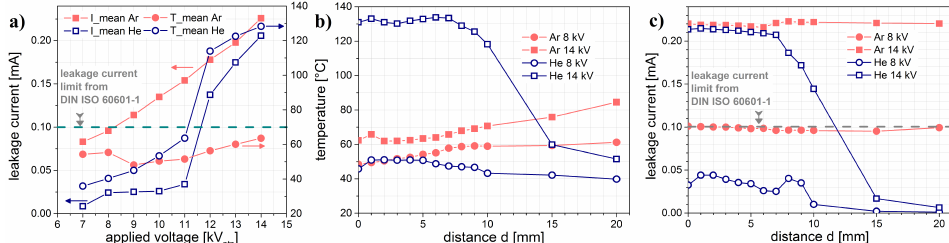
Figure 7. Measured values of patient leakage current and temperature for different voltage and distance settings in helium and argon. ( a ) shows the AC-leakage current for various applied voltages and the temperature for d = 5 mm to a copper surface (the DC-leakage current is below the detection limit of 1 µ A for all conditions); ( b ) shows the temperature as a function of distance for two applied voltages (8 and 14 kV pp ); ( c ) shows the AC-leakage current for different distances for two investigated voltages (8 and 14 kV pp